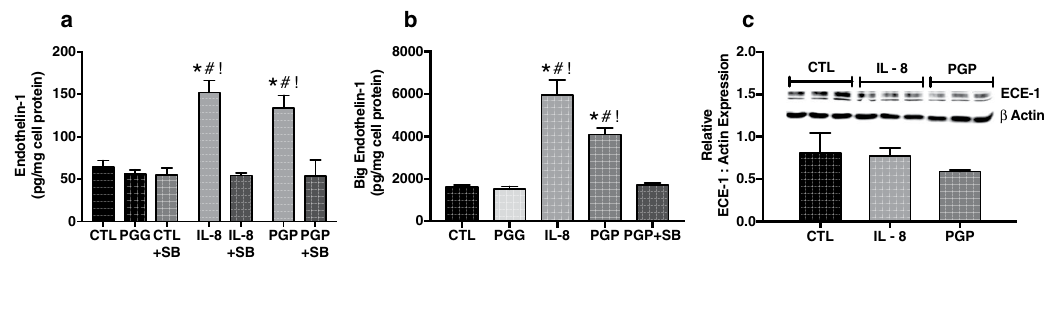
Figure 1. Acetylated PGP increases human aortic endothelial cell production of endothelin-1 via CXCR2 in vitro . ( a ) Cultured human aortic endothelial cells were treated with PGG, IL-8, and PGP. Compared to cell lysates from untreated cells (CTL) and PGG, both IL-8 and PGP caused a significant increase in endothelin-1 production ( * # P < 0.01 compared to CTL and PGG, n = 5 experiments). Importantly, pre-treatment with the CXCR2 antagonist SB225002 (SB) ablated the effects of both IL-8 and PGP ( ! P < 0.01 compared to CTL, PGG and SB225002 treated groups, F = 14.3). ( b ) Separate experiments further observed that IL-8 and PGP treatment increased big endothelin-1 production from endothelial cell lysates in a CXCR2 dependent manner ( * #! P < 0.0001 compared to CTL, PGG and PGP co-treated with SB225002, F = 32.3, n = 3 experiments). ( c ) Neither IL-8 nor PGP altered total protein expression of Endothelin Converting Enzyme (ECE) -1 when assessed by western blot analysis (bar graph from n = 3 experiments, P = 0.20, F = 2.0, inset Illustrates representative immunoblot of ECE-1 compared to β actin